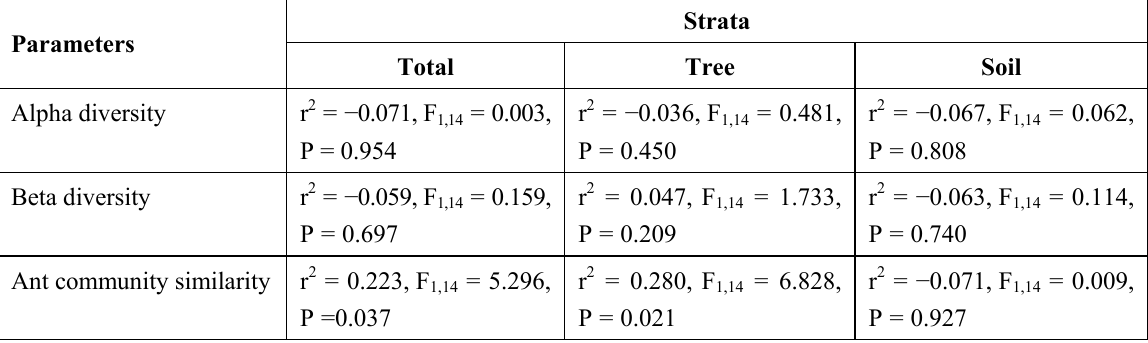
Table 3. Linear model between precipitation and alpha diversity, beta diversity and community similarity in each stratum, based on 16 cacao agroforestry